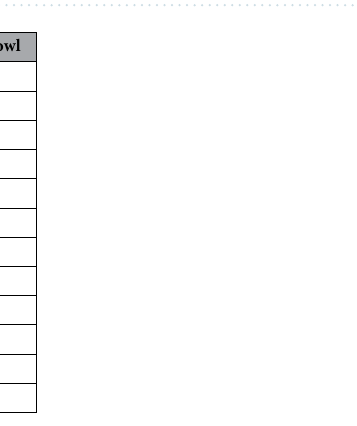
Table 2. Table showing the information on each individual wolf and their capture date with the number of howls were used in this analysis.